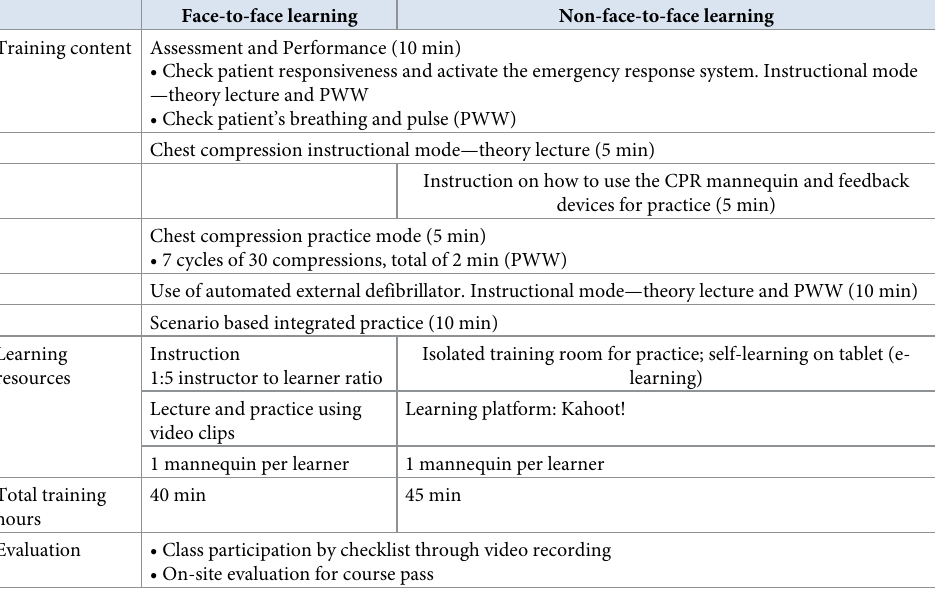
Table 1. Course process of the face-to-face and non-face-to-face formats for basic life support